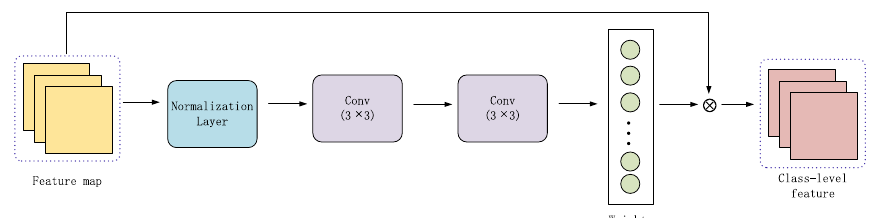
Fig. 4 The structure of the weight fusion